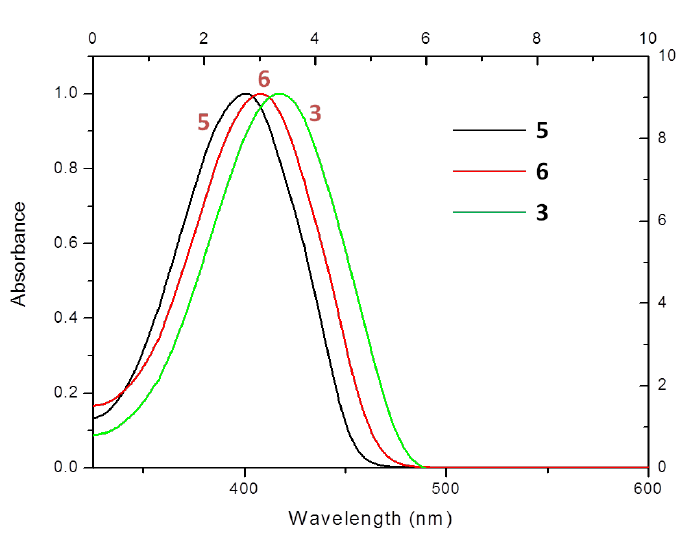
Figure 3. UV-Vis spectra of 3 , 5 and 6